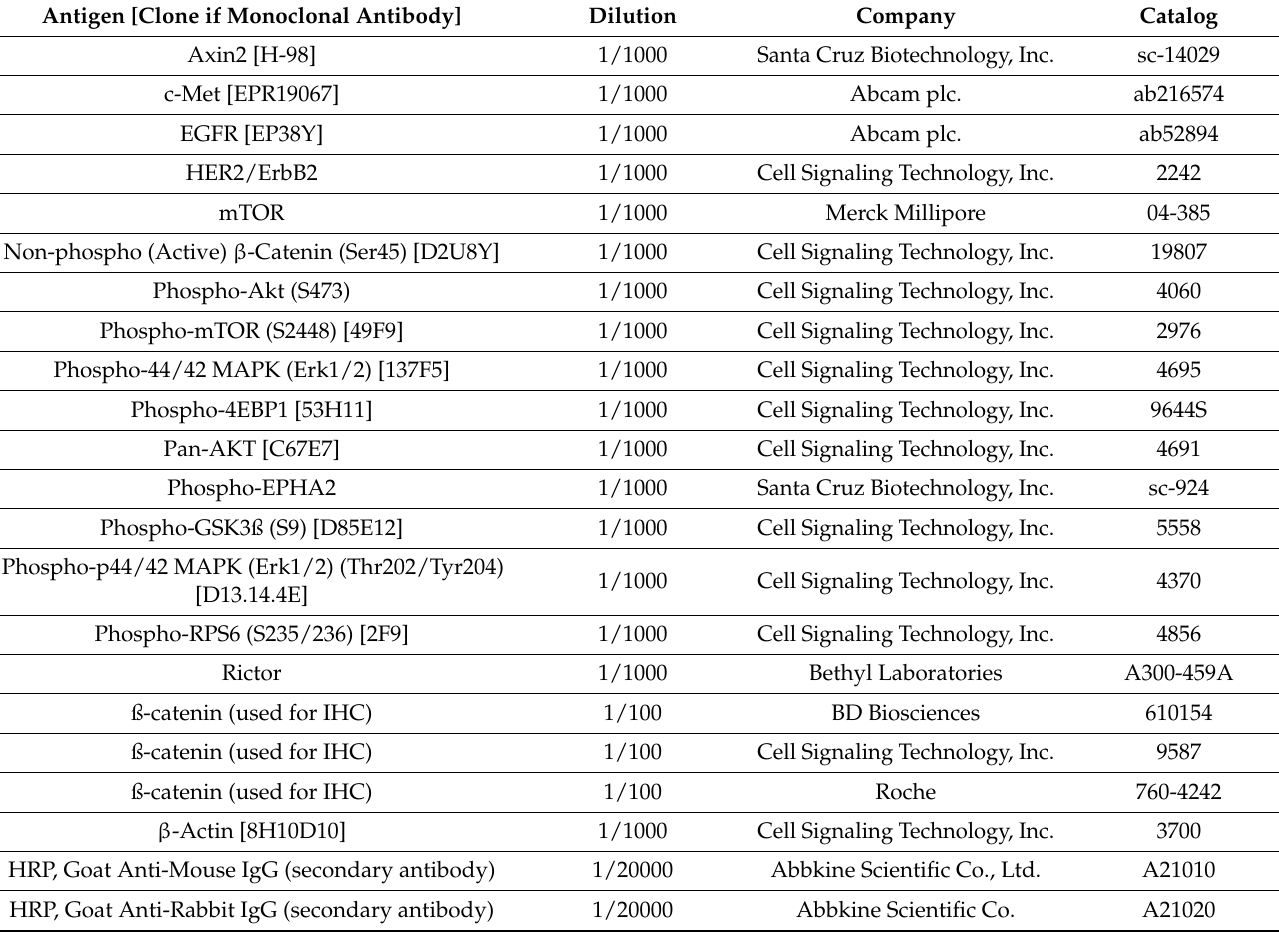
Table 1. List of antibodies used for Western Blotting and immunohistochemistry (IHC).